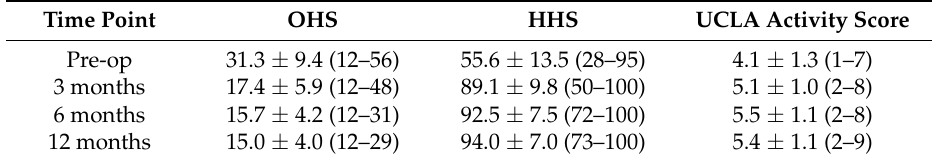
Table 2. Clinical scores preoperatively, and at 3, 6, and 12 months postoperatively.